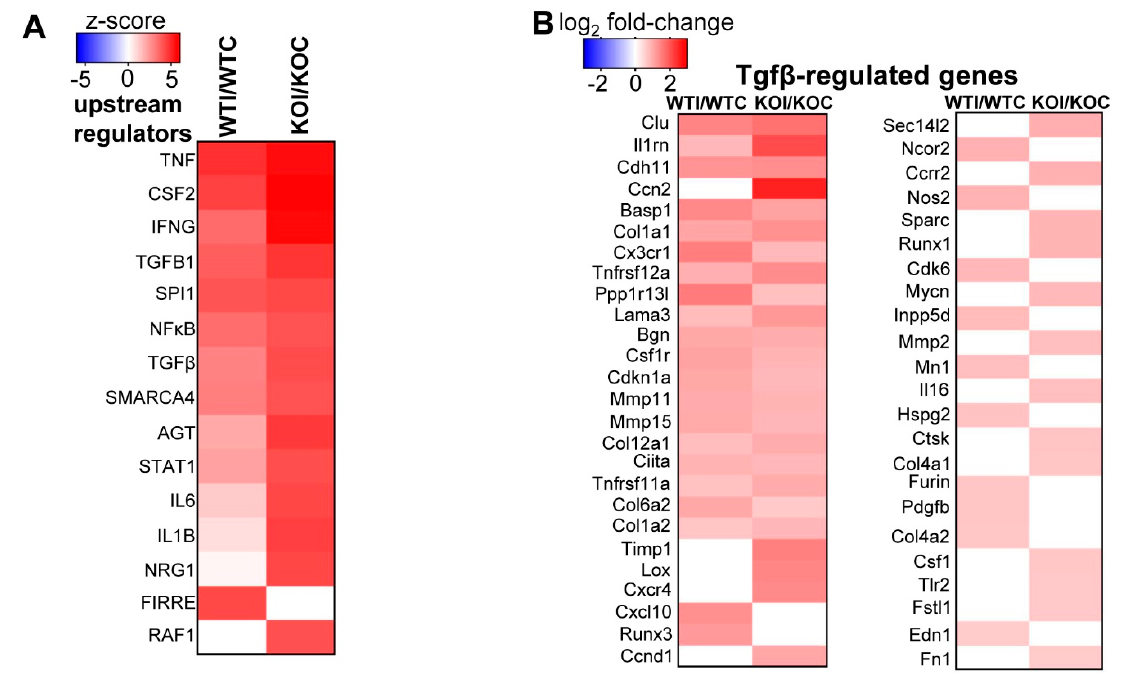
Figure 7. ( A ) Comparison of predicted upstream regulators of mRNAs di ff erentially expressed after iodide treatment in WT mice as compared to Nrf2 KO mice (WTI / WTC vs. KOI / KOC, z -score ≥ 4 and p < 0.01). Red color indicates upregulation (positive z -score), while white color indicates absence of enrichment of the upstream regulator. The graph was generated by the comparison analysis of IPA. ( B ) Gene expression heatmap of genes that participate in the fibrosis pathway, which is predicted to be upregulated by the enriched upstream regulator TGF β after iodide. Red color indicates ≥ 1.5-fold upregulation ( p < 0.05), while white color indicates gene expression change < 1.5-fold and / or p ≥ 0.05. The right column continues after the left one. Genes are presented from top to bottom from lower to higher p -value in either comparison (WTI / WTC, KOI /